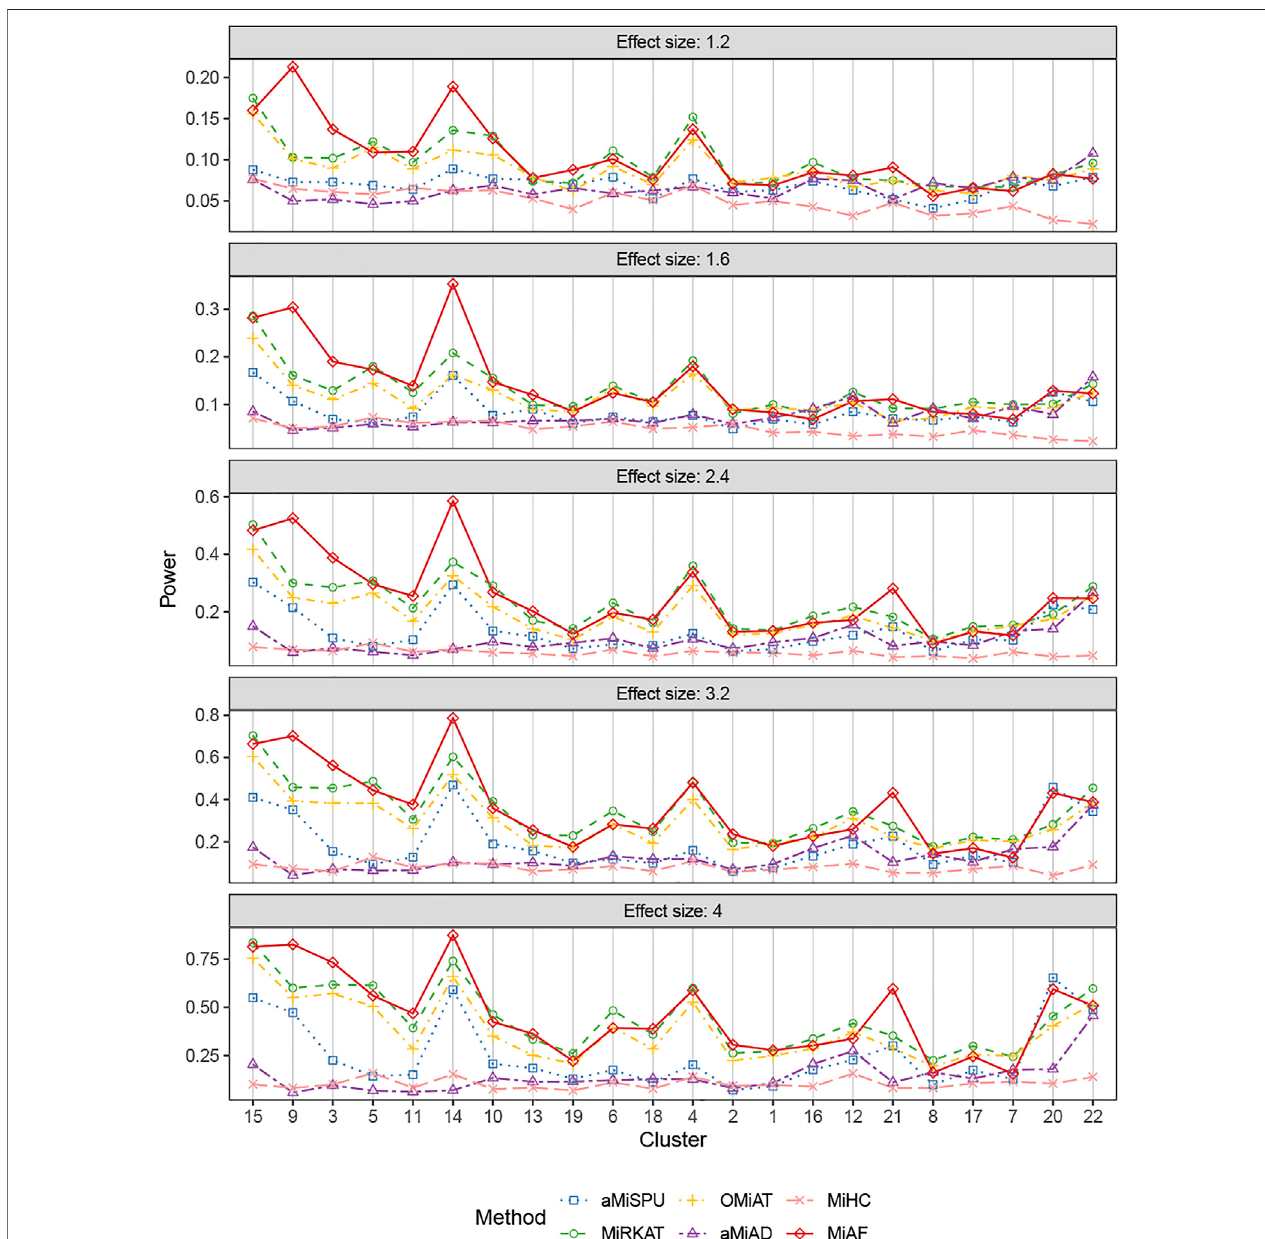
FIGURE 3 | Power comparison for binary outcomes under the correlated case of scenario 1. A total of 616 OTUs were divided into 22 clusters. The covariates Z i 2 and OTUs X i · were correlated. The effect size was set as 1.2, 1.6, 2.4, 3.2 and 4. The 22 clusters were sorted by the sum of estimated mean absolute abundance of the OTUs within the cluster that was truly associated from the greatest to the